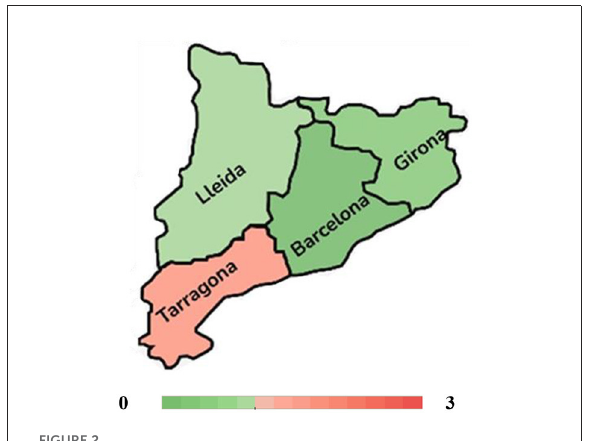
FIGURE2 Identification of the exporting (red) and domestic-supply (green) provinces in Catalonia based on the relationship between the consumption per capita of vegetables (excluding potatoes) in Catalonia (MAGRAMA, 2014) and the amount of product harvested per person in 2020 (DARP, 2020) (author source).